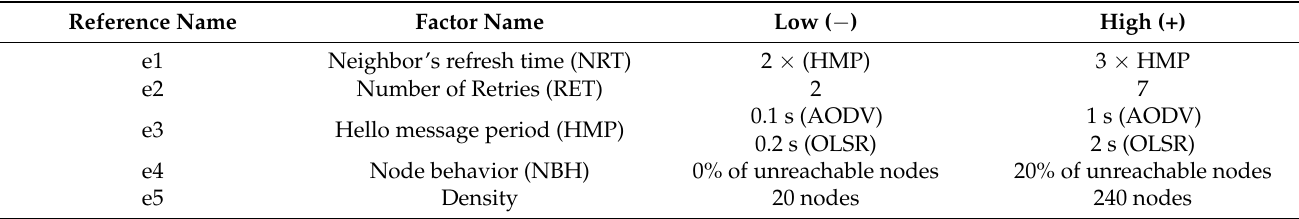
Table 2. Simulator parameters.